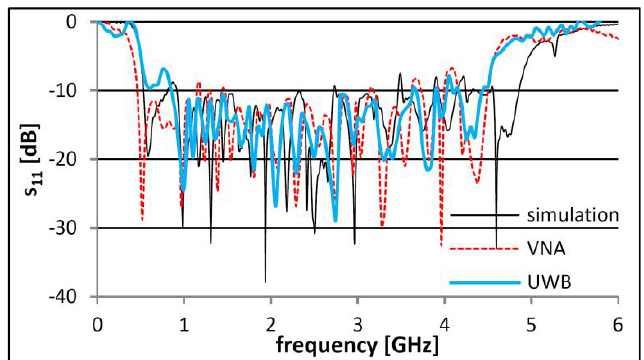
Figure 6. The simulated and measured values of parameter s 11 for the manufactured antenna with CPW feeding.